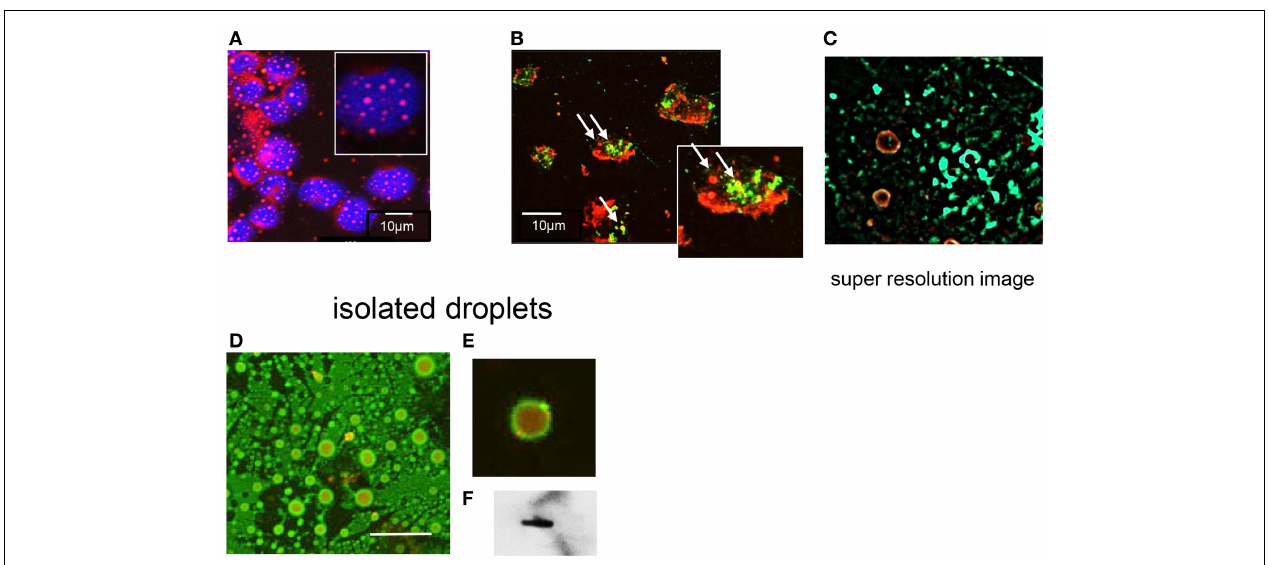
distinct yellow staining of their membranes, indicative of a close association of T2R38 with the droplet membrane. (D) The images show isolated lipid droplets stained with Nile red and anti-T2R38; localization of T2R38 on the droplets membrane is seen especially in the zoomed image (E) . (F) shows a blot of isolated droplets with